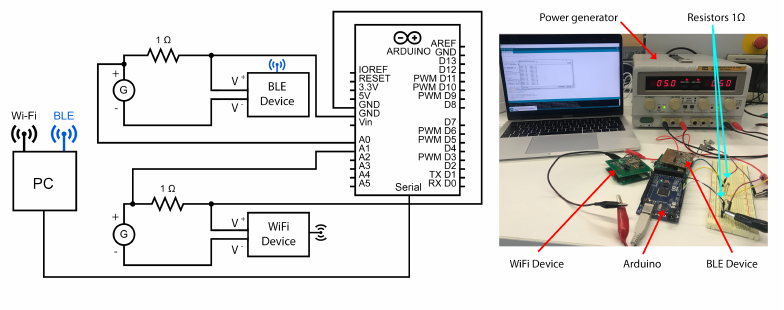
Figure 8. Test Bench: The BLE device is connected to the computer via BLE, and the Wi-Fi device is connected via Wi-Fi. Both devices are connected to a power generator with fixed voltage, a 1 Ω resistor and an Arduino micro-controller allows measurement and recording of the flowing current into both devices. The PC reads the power consumption from